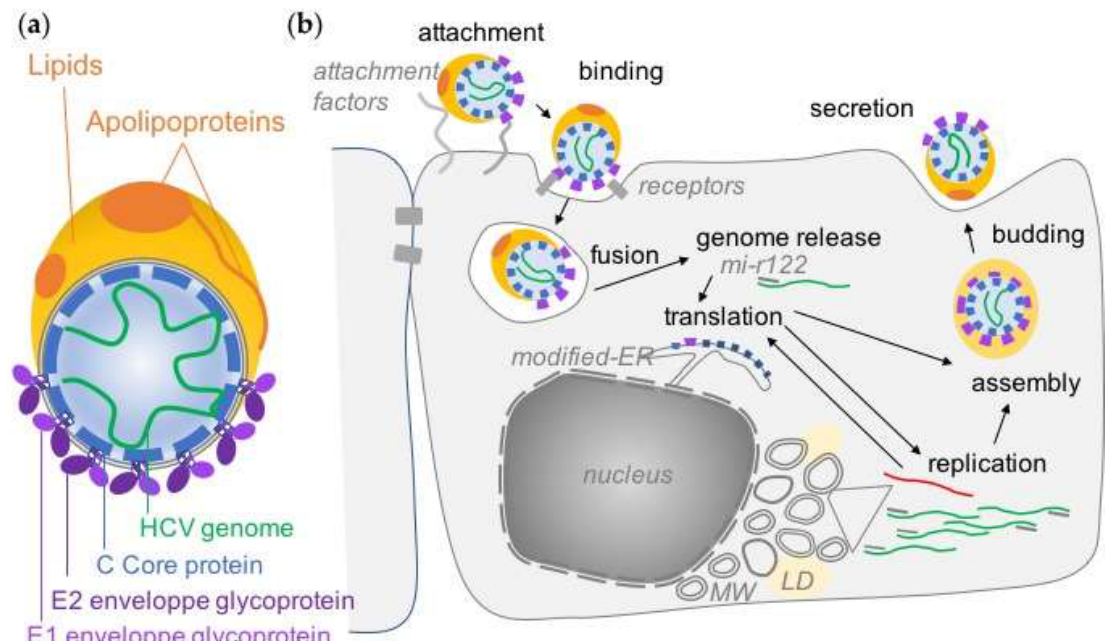
Figure 1. HCV lipoviroparticles and the virus life cycle. ( a ) HCV particles contain a positive strand RNA genome (in green) associated with Core proteins, enveloped by a membrane in which E1 and E2 glycoproteins are embedded and are tightly associated with lipids and apolipoproteins. ( b ) HCV life cycle. The different steps of HCV life cycle are indicated in black. ER Endoplasmic Reticulum. MW Membranous Web. LD Lipid Droplets. The negative strand replication intermediate in red.